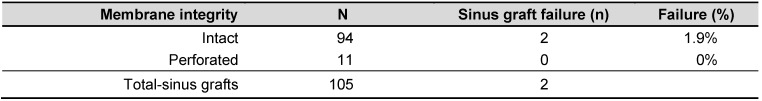
Membrane integrity at augmentation procedures of failed grafts